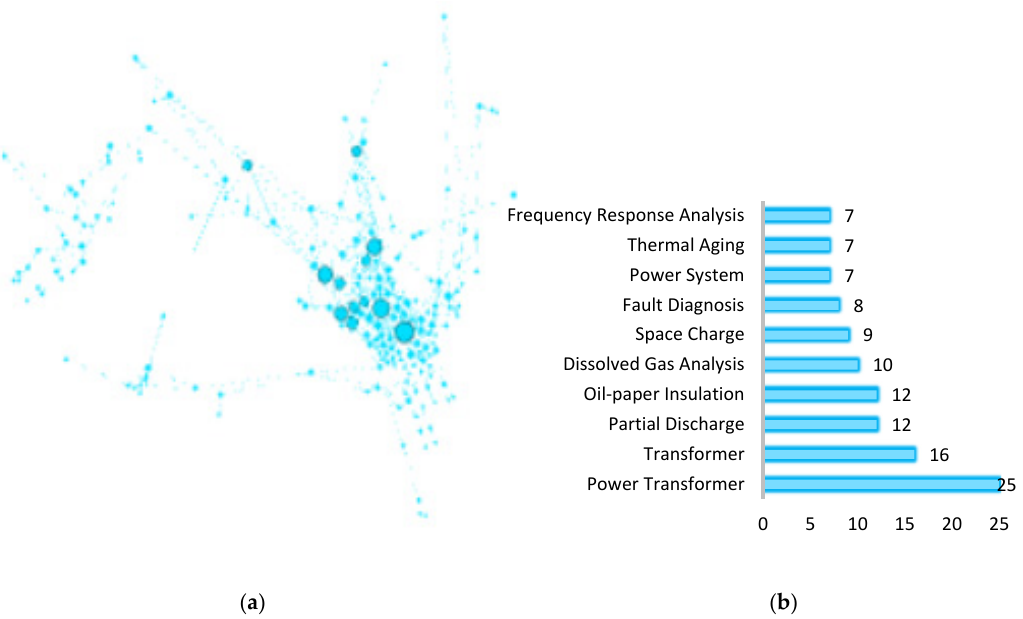
Figure 25. Preventive techniques in power transformers community: ( a ) manuscripts published, ( b ) keywords.